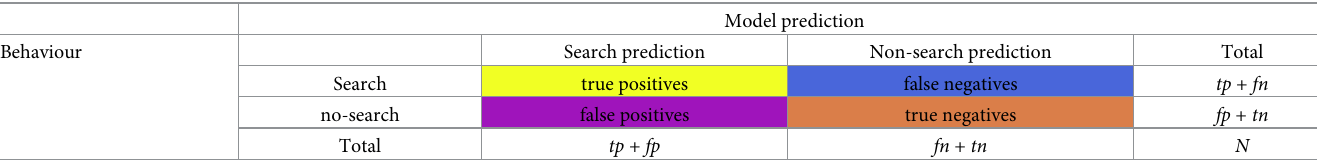
Table 2. The confusion